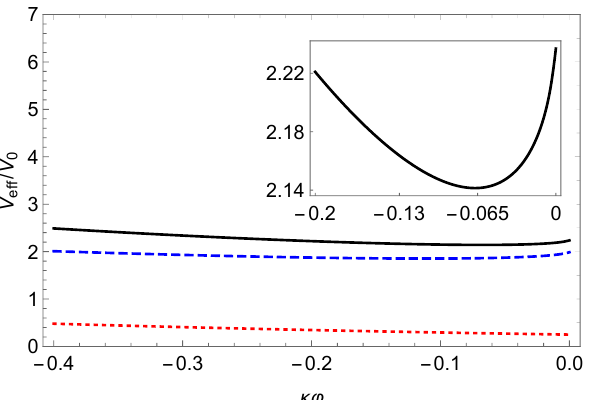
Figure 1 . The e(cid:11)ective potential of Starobinky model with (cid:12) = 2, n = 1, and V e(cid:11) being normalized by V 0 = R c . Here, the dotted red line corresponds to original potential, dashed blue line to matter 2 (cid:20) 2 contribution with (cid:0) T (cid:22) (cid:24) (cid:26) (cid:3) (cid:24) 10 (cid:0) 47 [GeV 4 ] (dark energy density), and solid black line to the (cid:22) e(cid:11)ective